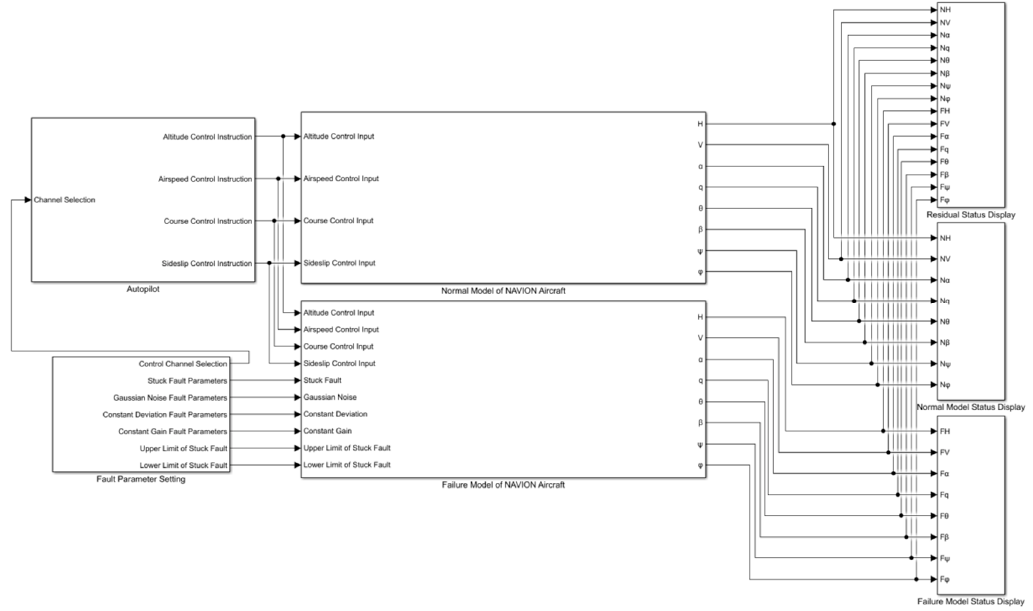
Figure 5. Simulation diagram of attitude sensor fault.